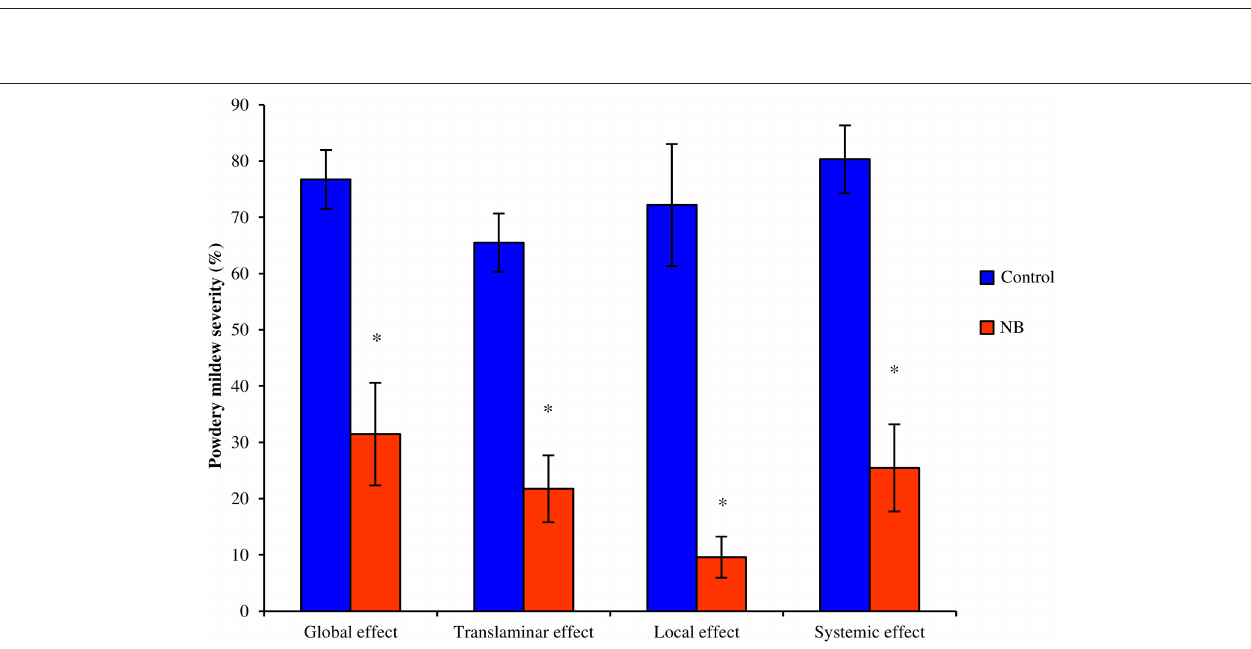
FIGURE 3 | Effect of nutrient broth against powdery mildew on zucchini plants under greenhouse conditions. Powdery mildew severity were evaluated on zucchini plants treated with nutrient broth (NB) or water (Control). Treatments were sprayed to both surfaces of each leaf (Full treatment), to the abaxial surface of each leaf (Abaxial treatment) or to the first four basal leaves (Basal treatment). Disease severity was assessed as the percentage of adaxial leaf area covered by white sporulation 14 days post-inoculation. Global and translaminar effect was calculated on all leaves of full and abaxial treatment, respectively. For basal treatment, scores of treated basal (Local effect) and untreated apical (Systemic effect) leaves were analyzed separately. F -test revealed non-significant differences between experiments ( P > 0.05 ) and data from two experimental repetitions were pooled. The mean severity and standard error values of eight replicates (potted plants) of two experiments are presented for each treatment. For each treatment, asterisks indicate significant differences between NB-treated and control plants according to t -test ( α = 0.05 )